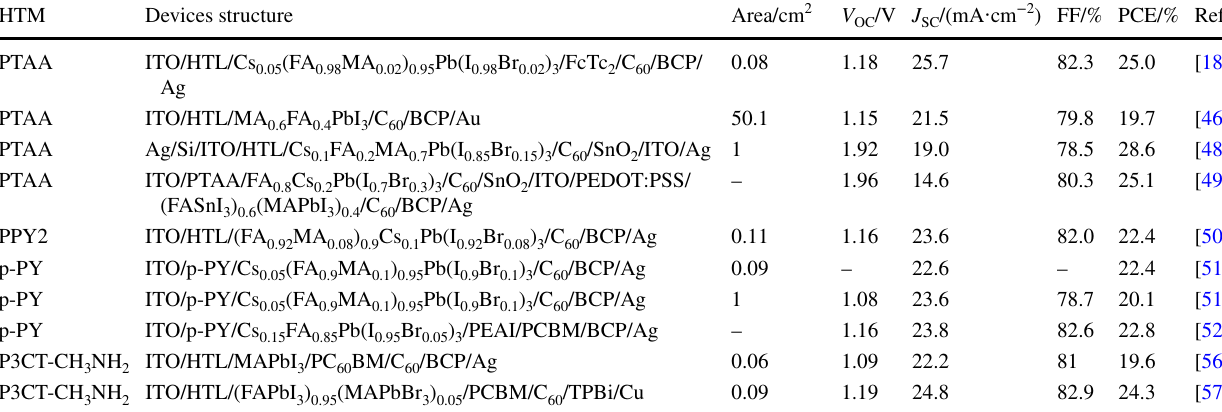
Table 1 Device structure and parameters of PVSCs based on distinct polymeric HTMs HTM Devices structure